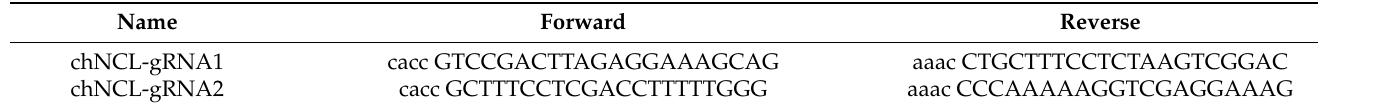
Table 1. Oligonucleotide sequences (5 (cid:48) -3 (cid:48) ) used for